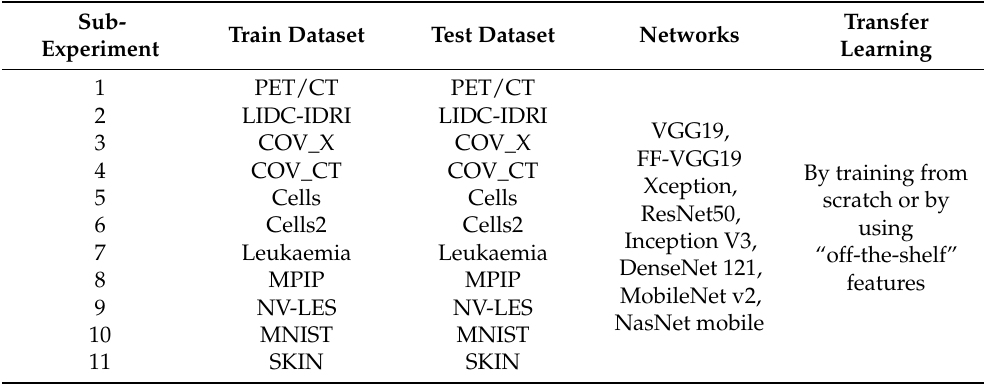
Table 3. Experiment setups for evaluating the training from scratch against feature extraction via transfer learning methodologies.